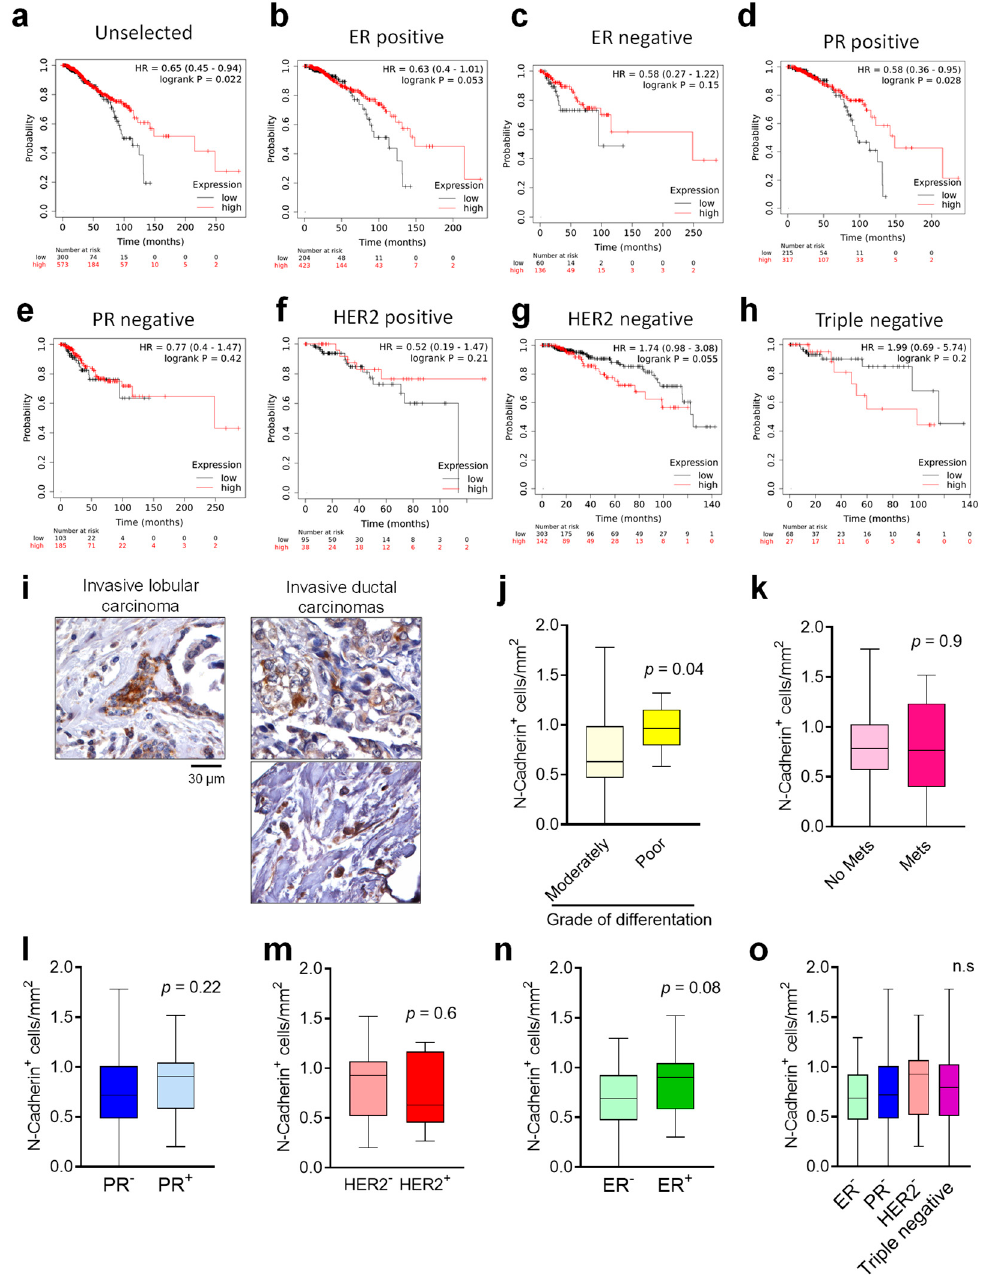
Figure 6. N-Cadherin expression in primary human breast cancers and correlation with survival. ( a ) Kaplan–Meier plots on 1229 public proteomics from primary breast cancers to correlate N-Cadherin protein expression with patient survival in unselected populations of 300 N-Cadherin Low and 573 N-Cadherin High samples, ( b ) in oestrogen receptor (ER)-positive of 204 N-Cadherin Low and 423 N-Cadherin High samples, ( c ) in ER-negative populations of 60 N-Cadherin Low and 136 N-Cadherin High samples, ( d ) in progesterone receptor (PR)-positive of 215 N-Cadherin Low and 317 N-Cadherin High and ( e ) progesterone receptor (PR)-negative populations of 103 N-Cadherin Low and 185 N-Cadherin High samples, ( f ) in HER2-positive populations of 95 N-Cadherin Low and 38 N-Cadherin High samples, ( g ) in HER2-negative populations of 303 N-Cadherin Low and 142 N-Cadherin High samples and ( h ) in triple negative populations of 68 N-Cadherin Low and 27 N-Cadherin High samples plotted against time (KMPlot ® ). ( i ) Breast cancer tissue array